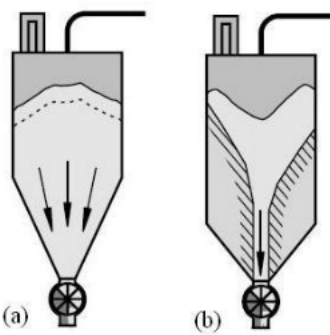
Figure 4. ( a ) Mass flow ( b ) funnel flow [67].